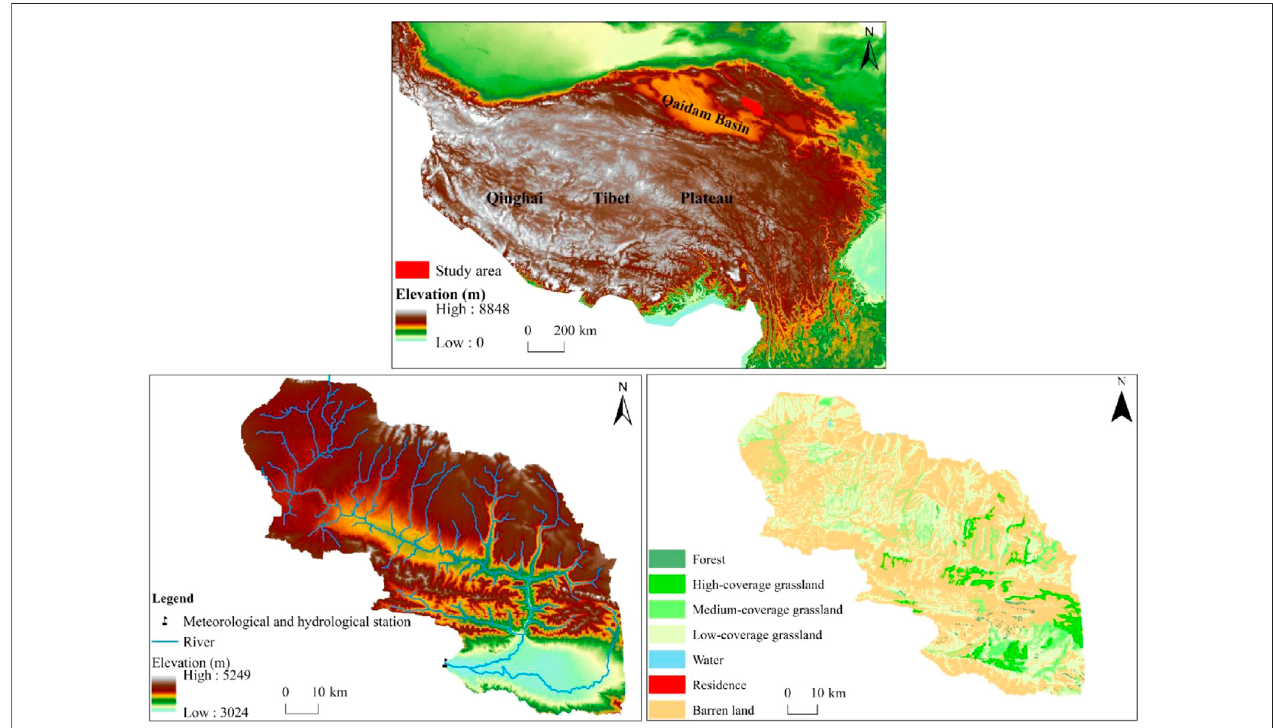
FIGURE 4 | The study